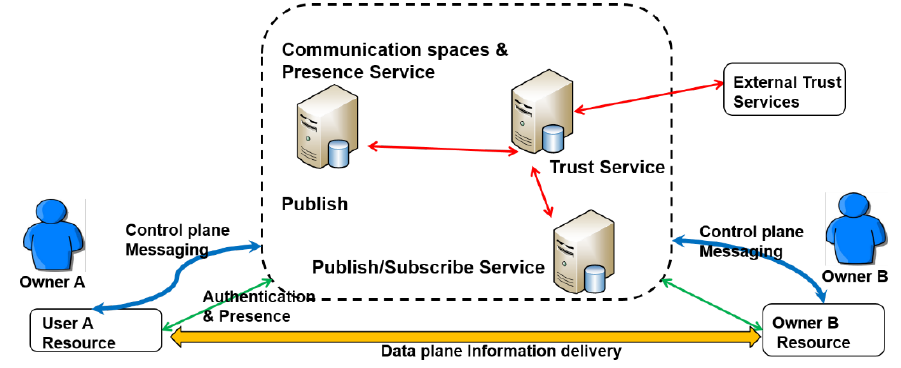
Figure 10. Data plane of CPS communication hub.